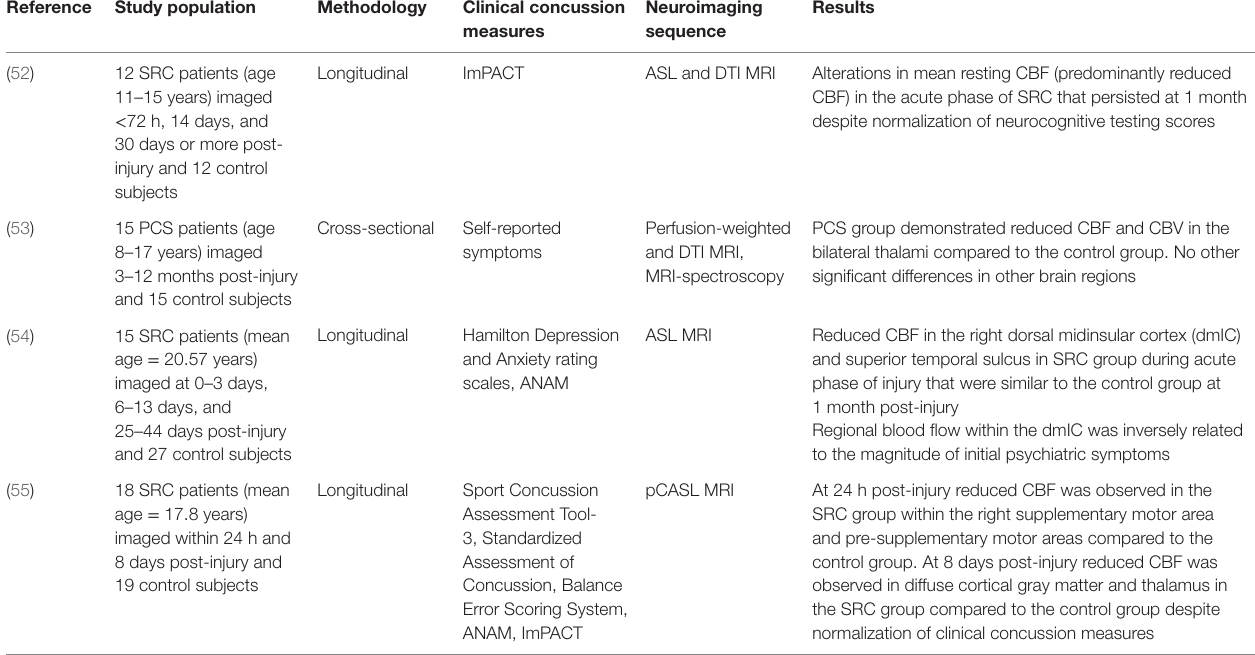
taBLe 1 | overview of studies examining resting cerebral blood flow in